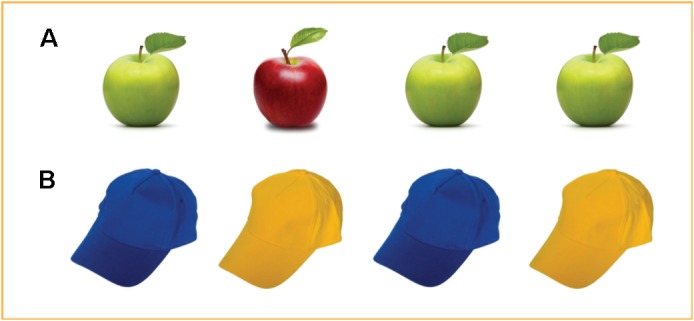
Example trials of the Social Mindfulness task (SoMi), displaying (A) an experimental trial (3:1 ratio presentation) where the participant’s choice can influence the choice options of the other player; and (B) a control trial (2:2 ratio presentation) where the choice has no social consequences. The stimulus was displayed for 5000 ms, followed by an inter-stimulus interval (0, 1000, or 2000 ms). Reproduced from (Lemmers-Jansen et al., 2018b).